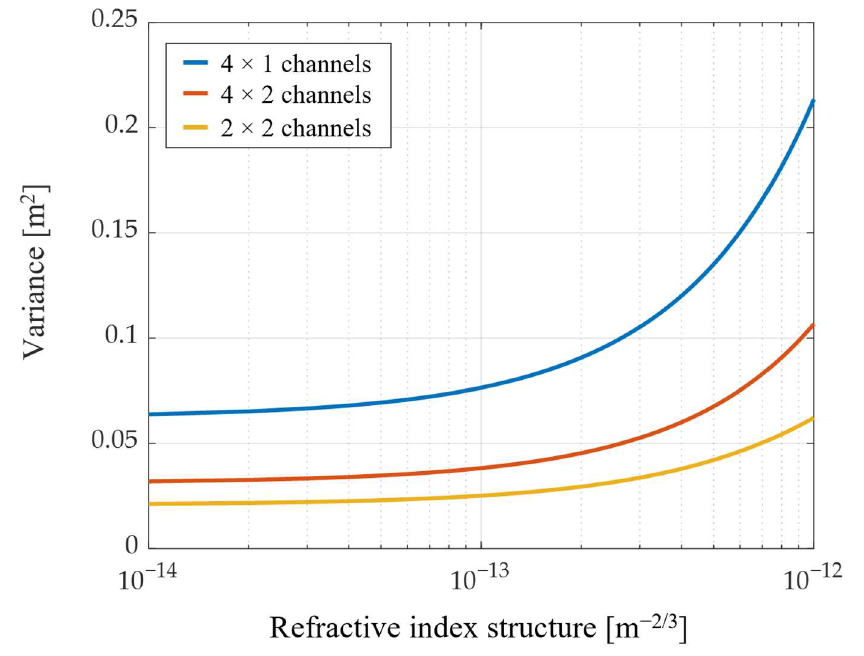
Figure 2. Variance of misalignment for different numbers of channels in MIMO transmissions.